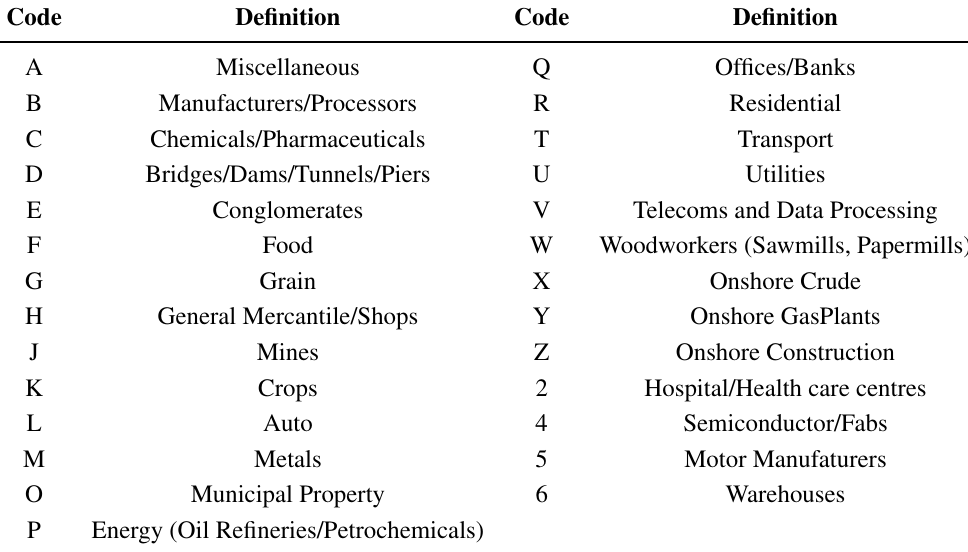
Table 3. Occupancy Level 2 definitions.